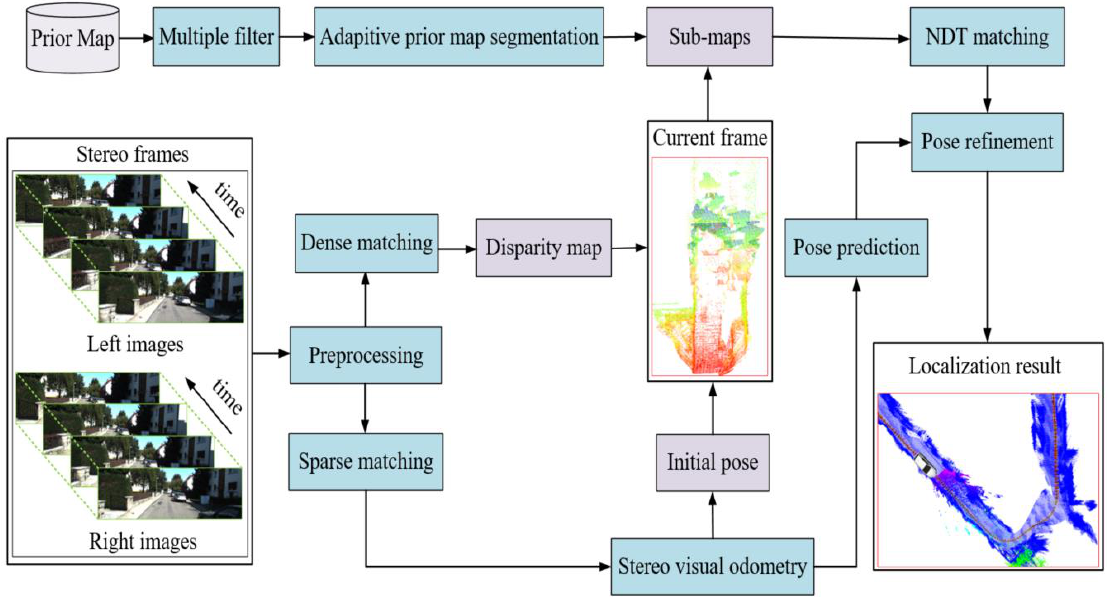
Figure 1. The proposed pipeline of autonomous vehicle localization.